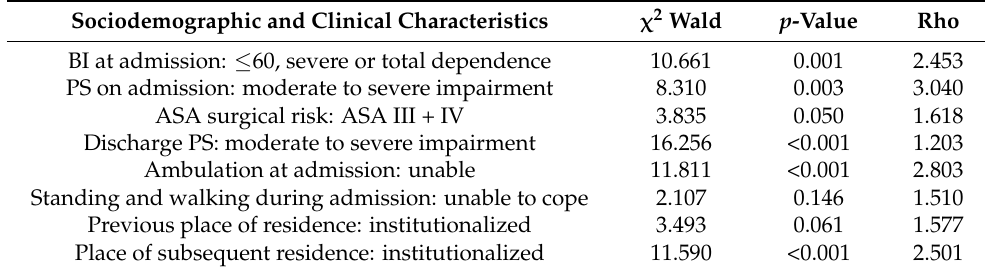
Table 4. Results of binary logistic regression to estimate the relationship between mortality at the sixth month and relevant sociodemographic and clinical characteristics.